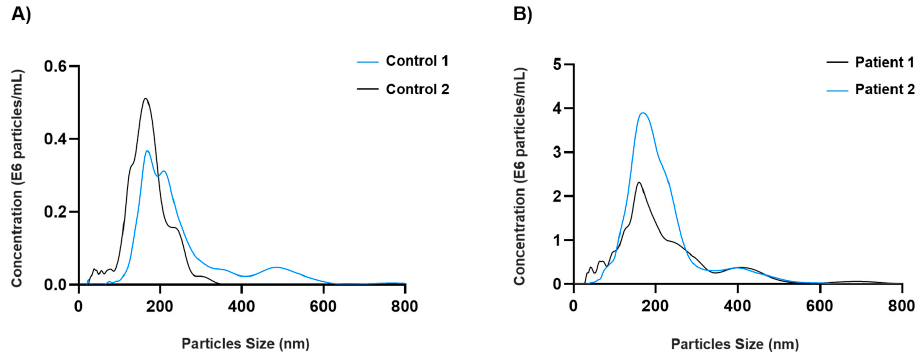
Figure 1. Size distribution and concentration of plasma exosomes by Nanoparticle Tracking Analysis (NTA). ( A ) Control 1 and 2 with a mean concentration of 0.497 and 0.503 × 10 8 particles/mL, respectively. ( B ) Patient 1 (no metastasis) and patient 2 (metastasis) with a mean concentration of 3.493 and 5.170 × 10 8 particles/mL,